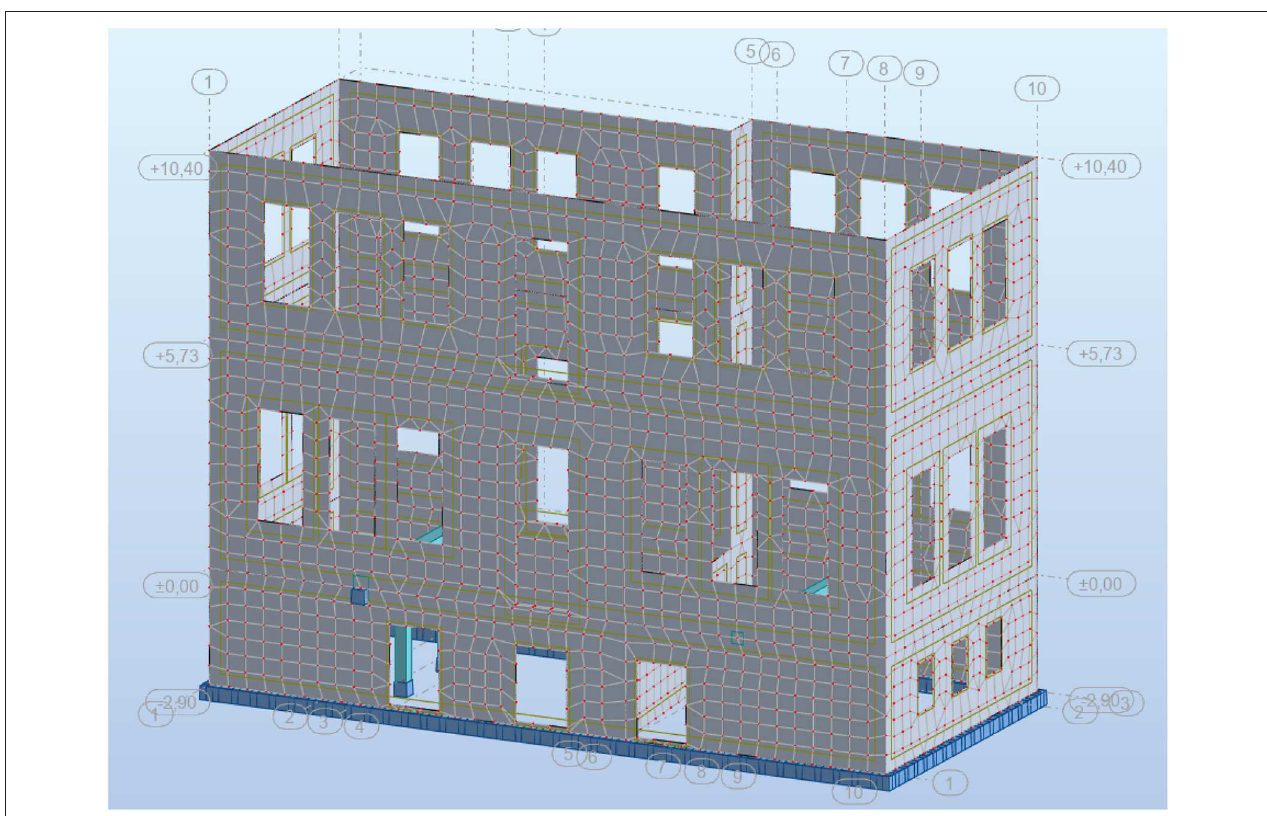
FIGURE 6 | Finite element model in Robot Structural Analysis software (Autodesk Robot Structural Analysis Professional, 2016).